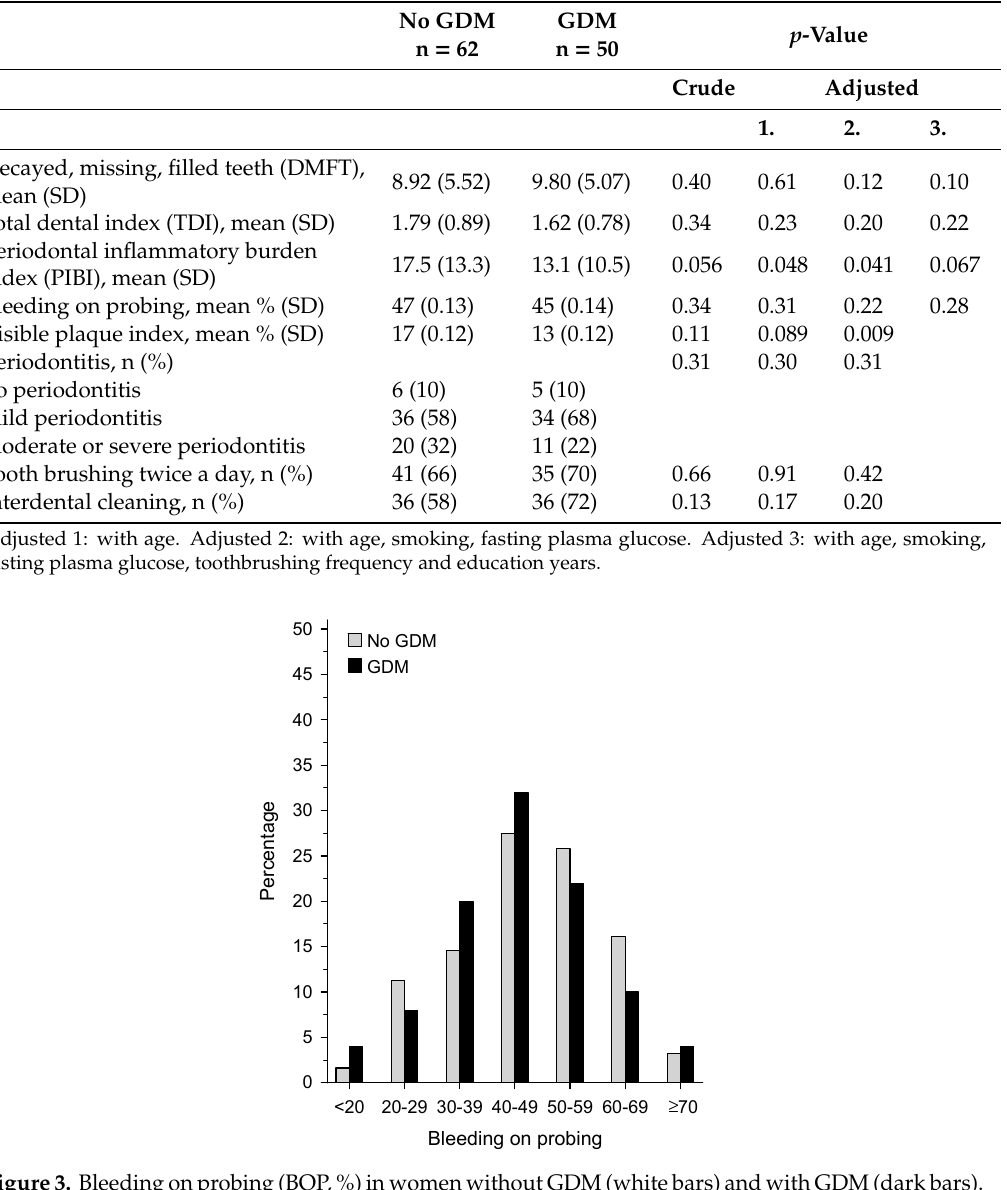
Table 2. Oral health parameters in women according to history of GDM.